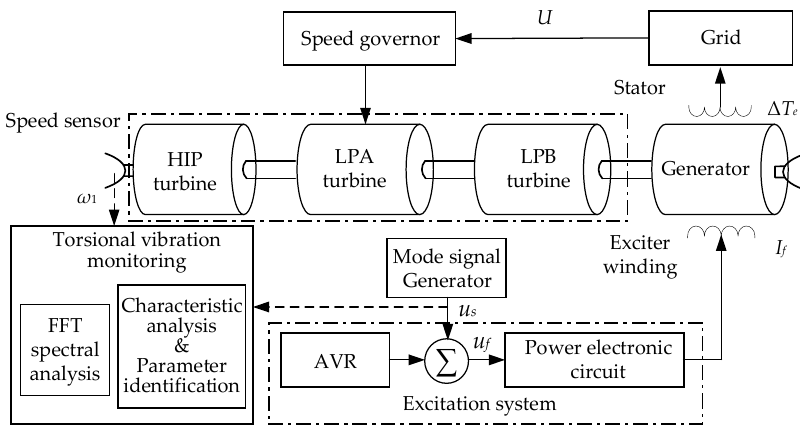
Figure 5. Basic principle of excitation-signal-injection method.